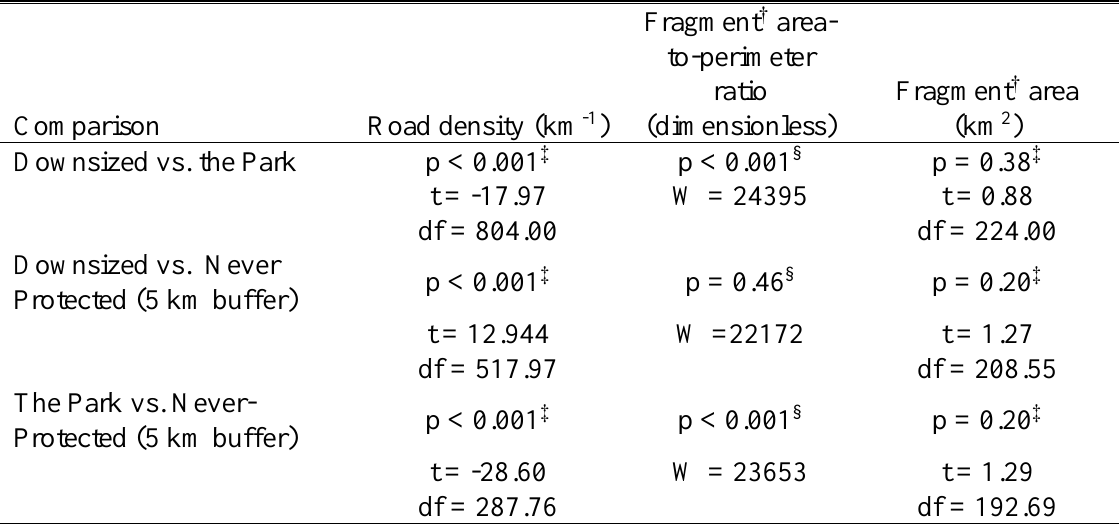
Table A1.13: Post-hoc results from Table A1.12. Habitat fragmentation at the Park scale for all land cover types using 5 km buffers for never-protected lands. Results are consistent with comparisons using a 1 km